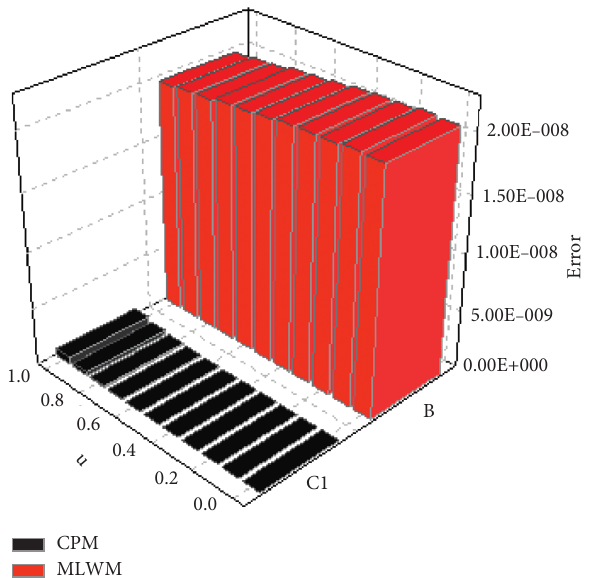
Figure 5: Exact and CPM solution graph for problem 2.